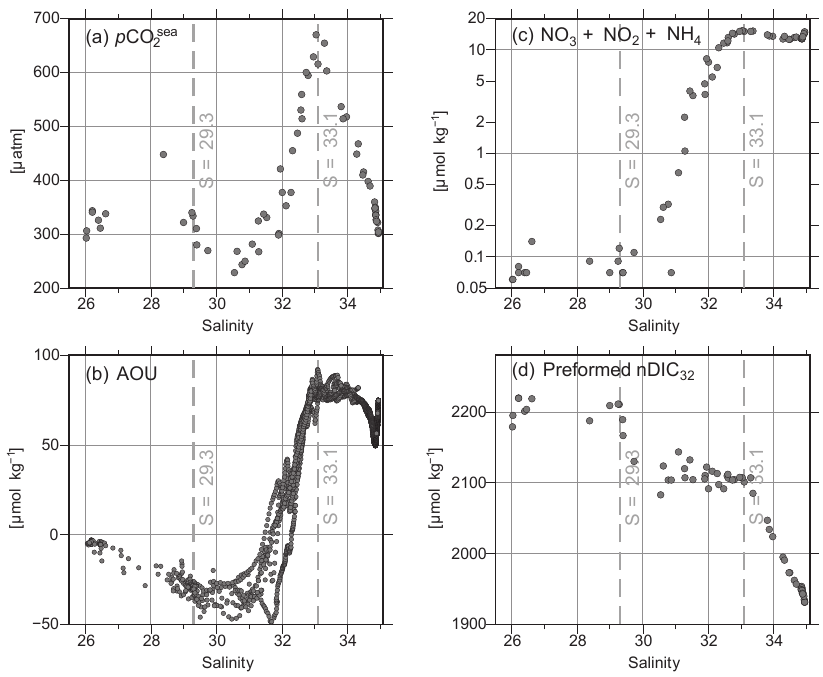
Figure 6. Variation in several parameters of Canada Basin water against salinity. (a) p CO sea utilization (AOU) from CTD cast data; (c) preformed nDIC 32 ( = {DIC − AOU · 117 / 170 } /S · 32) in discrete bottle samples and dissolved nitrate (NO 3 + NO 2 + NH 4 ) in logarithmic scale in discrete samples. Salinity of rWML ( S = 29.3) and PWW ( S = 33.1) is indicated as gray dotted